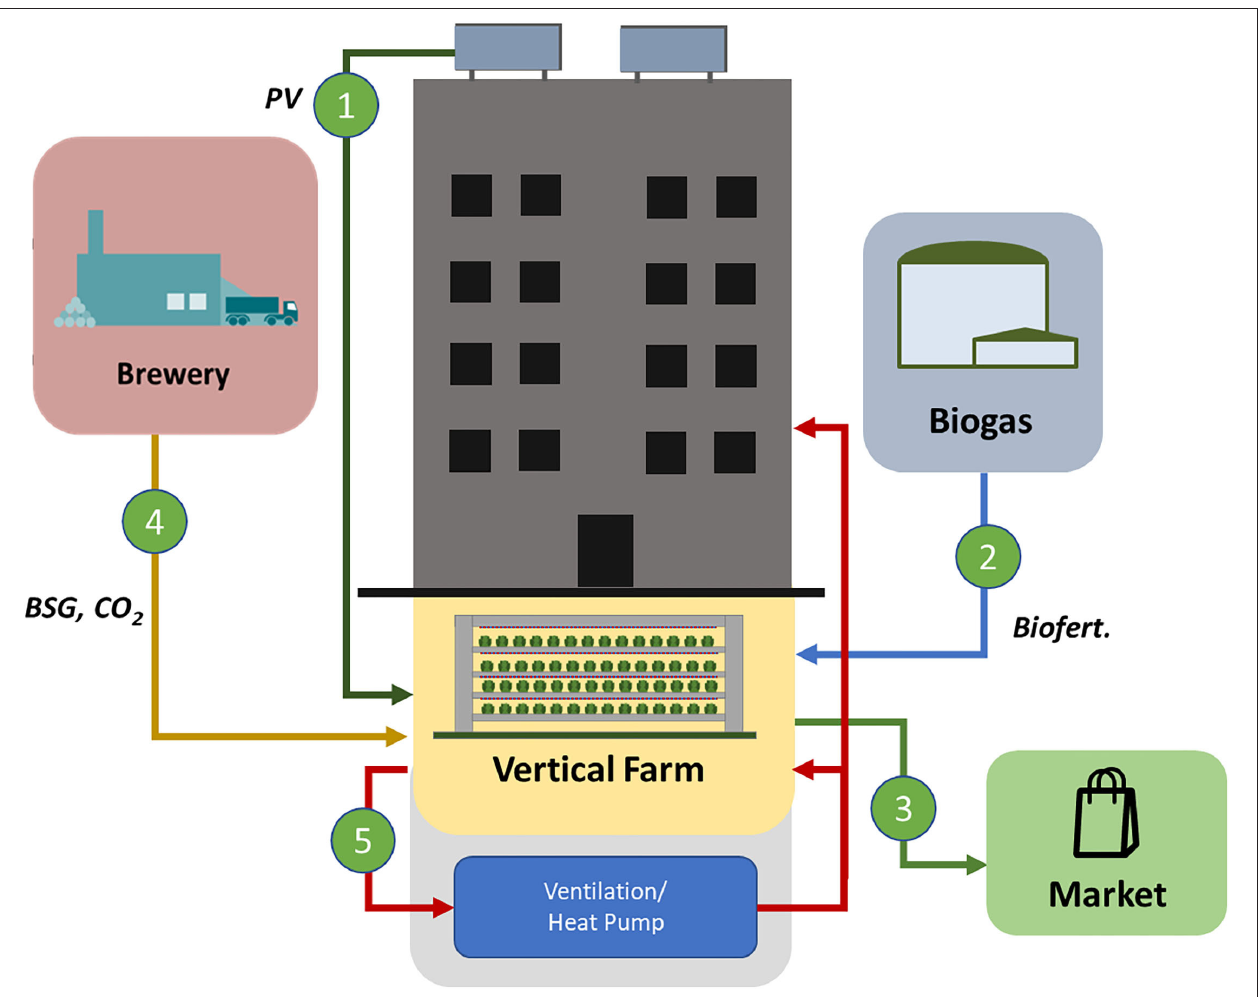
FIGURE 2 | Depiction of material and energy exchanges between the building, the vertical farm, and connected systems for the different synergistic scenarios. These include (1) integration with rooftop photovoltaics (PV) in the PV15 and PV30 scenarios, (2) utilizing biogas digestate fractions as a biofertilizer ( Biofert. ), (3) employing local market delivery services in the Local Market scenario, (4) utilizing brewers spent grain (BSG) and Carbon dioxide (CO 2 ) from a local brewery in the BrewInteg scenario, and (5) integrating waste heat from the LEDs with the heating system of the host building in the Bldng Int. HP-WWTP and Bldng. Int. DH-W2E